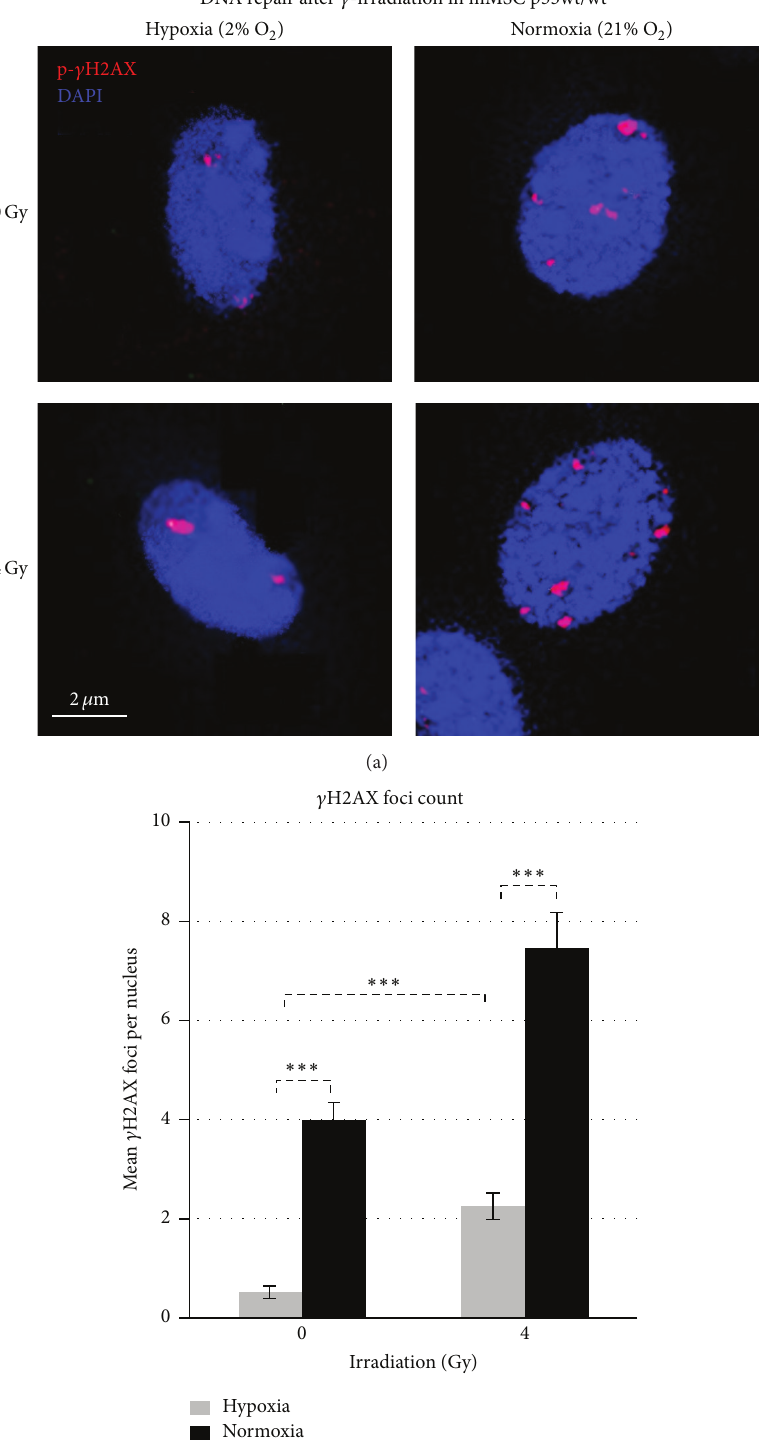
Figure 3: Effects of oxygen levels on the number of repair foci in sham-irradiated and 4 Gy irradiated p53wt/wt mMSCs. (a) Sham-irradiated (0Gy) 𝛾 H2AX foci formation under normoxic cultures (right upper image) and hypoxic cultures (left upper image) and additionally 90 min after exposure to 4 Gy 𝛾 -irradiation (lower images). (b) Quantification of 𝛾 H2AX foci in 50 p53wt/wt mMSC nuclei depicted as mean values ± standard error of the mean (3 biological